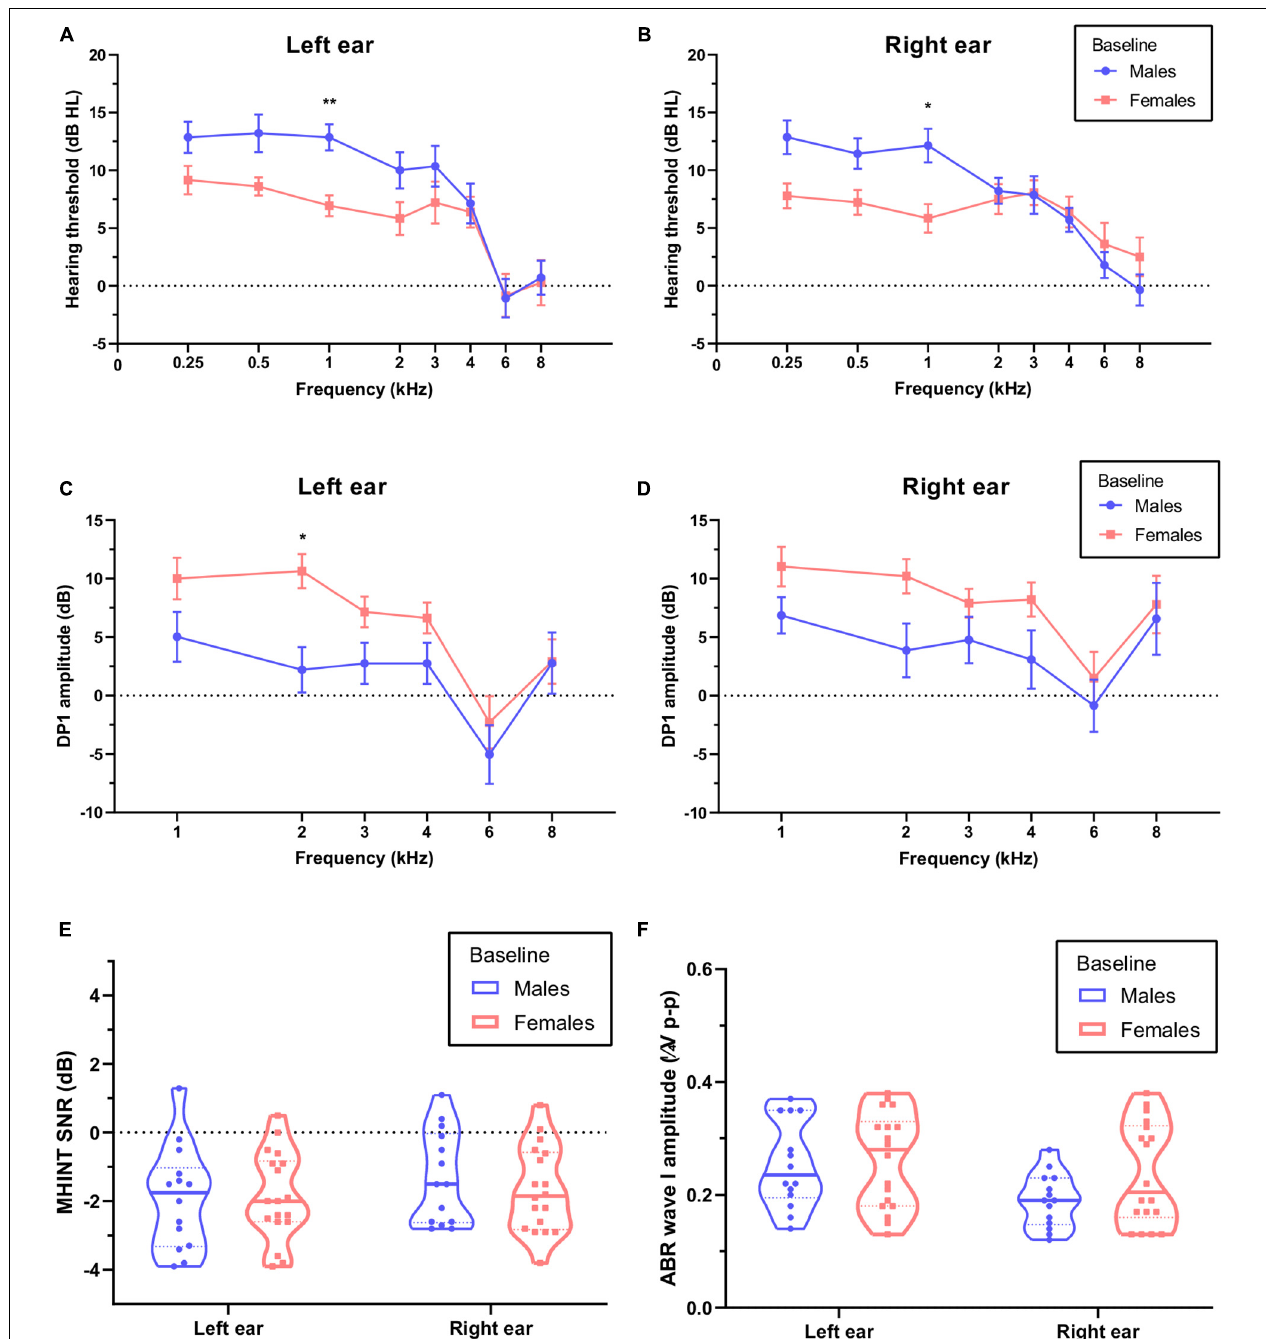
FIGURE 2 | Comparison of auditory function between males and females at baseline. Females (pink) show a lower pure-tone audiometry (PTA) threshold at a 1 kHz frequency than males (blue) for the left ear (A) and the right ear (B) . Females show higher distortion product otoacoustic emission (DPOAE) amplitudes at a 1 kHz frequency than males for the left ear (C) but not the right ear (D) , analyses were performed by the two-way repeated measures ANOVA. There were no statistically significant differences in signal-to-noise ratios (SNRs) of Mandarin Hearing in Noise Test (MHINT) (E) and auditory brainstem response (ABR) wave I amplitudes (F) between males and females for either ear, analyses were performed by the unpaired t -test. * P < 0.05, ** P < 0.01.